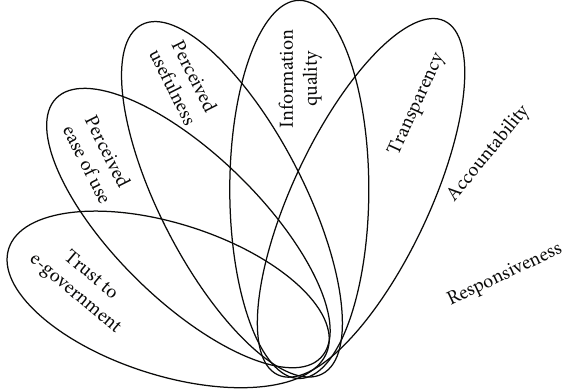
Figure 5: Path 2 contributes to high e-government participation (HEP) ( consistency = 0 : 981 and coverage = 0 : 820 ). Note: the solid ellipse represents the presence of the condition. If no ellipse is displayed, it belongs to the “ do not care ” condition.